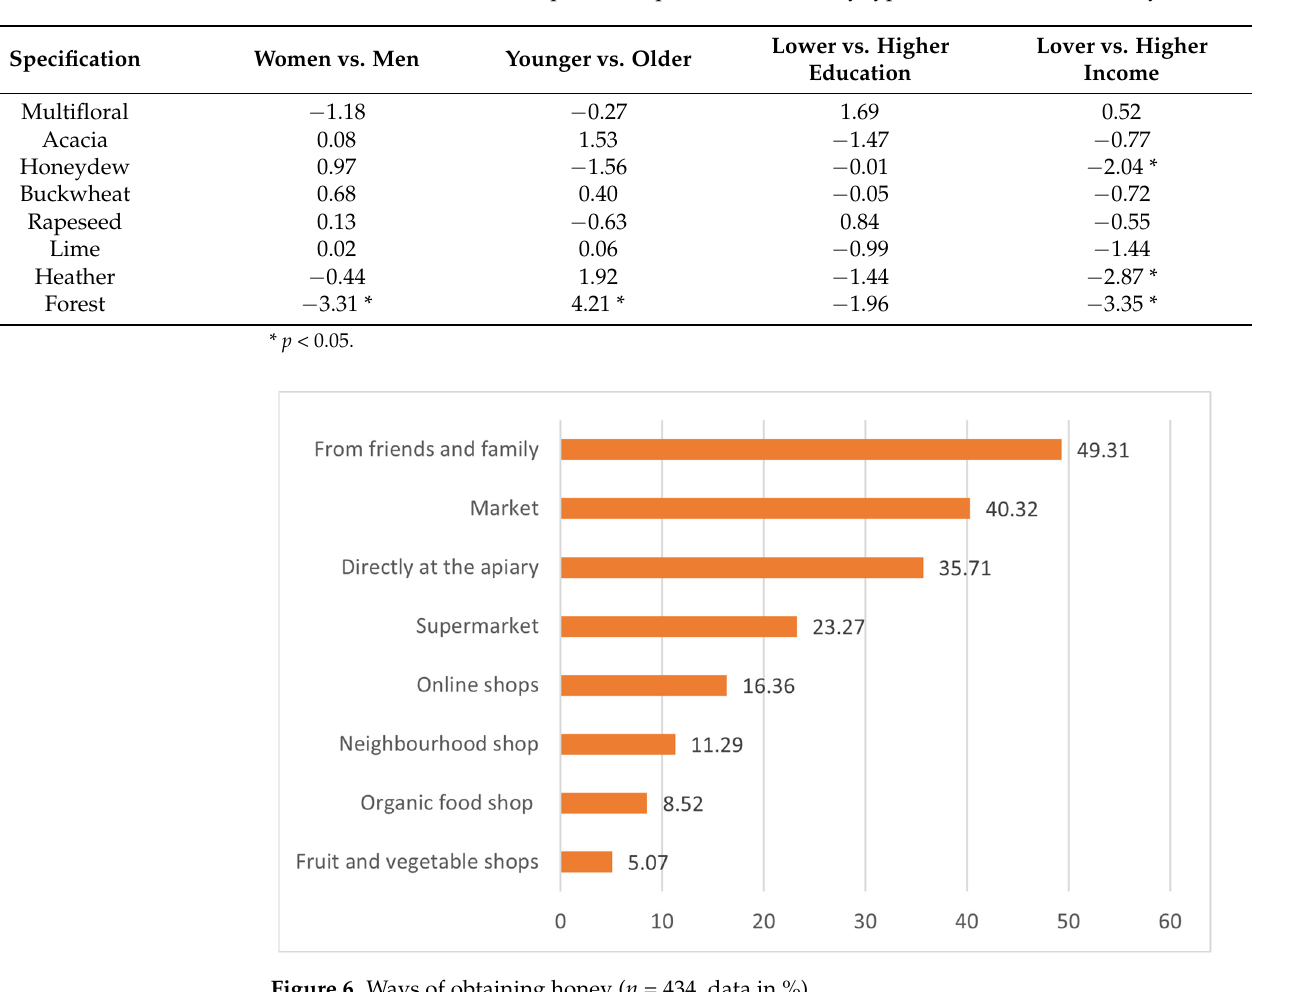
Figure 5. Preferences in types of honey ( n = 434, data in %). Table 4. Determinants of respondents’ preference for honey type ( n = 434, Mann–Whitney test).